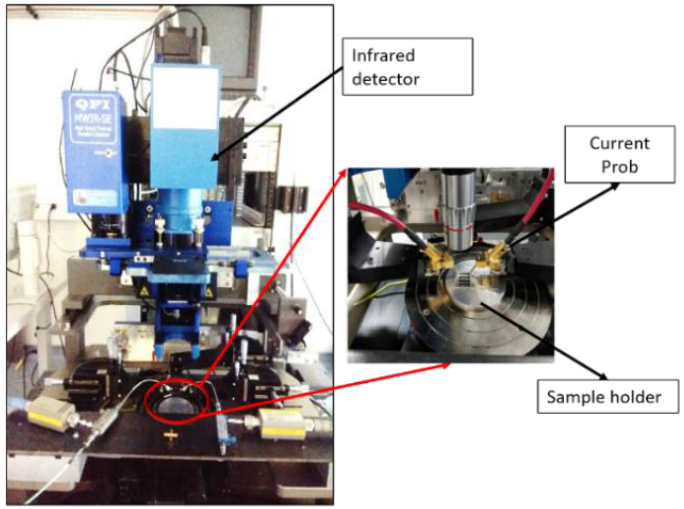
Figure 12. MWIR temperature microscope and measurement set-up.